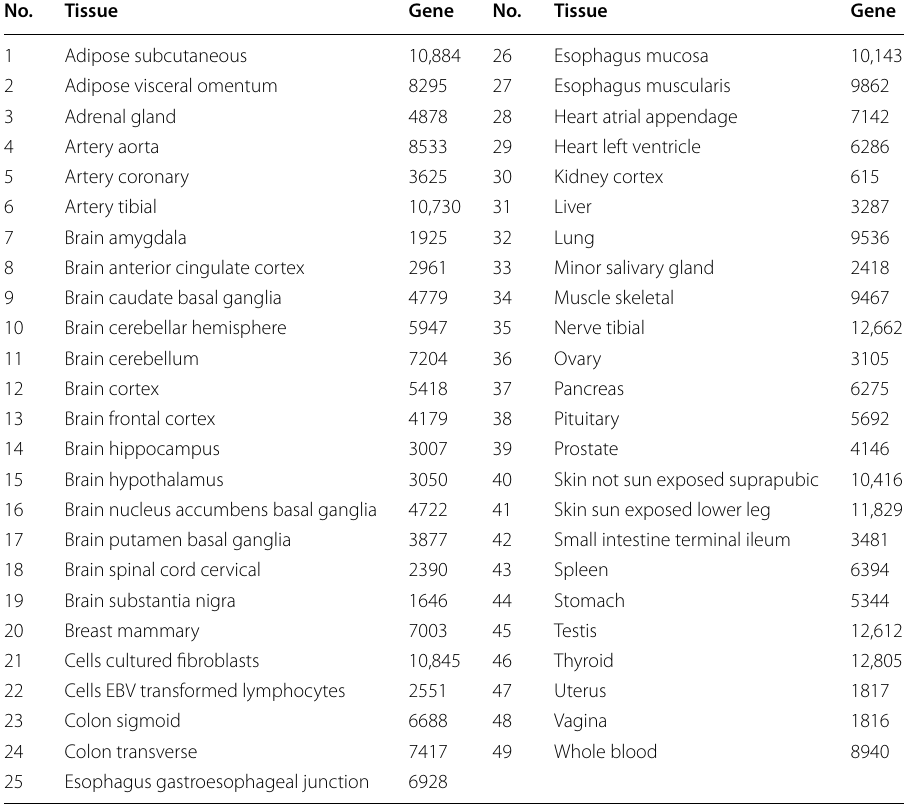
Table 1 The 49 human tissues and their tissue-specific genes with at least 25 SNPs. A total of 305,572 genes is